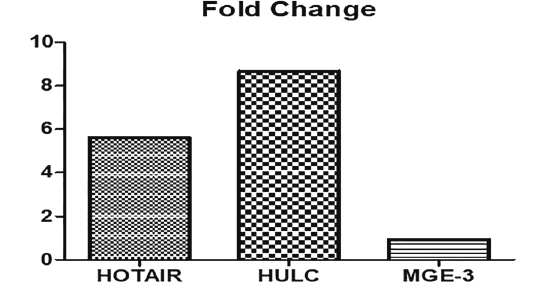
Figure 3 - The relative expression levels of HOTAIR (a), HULC (b) and MGE-3 (c) in healthy control and patients with